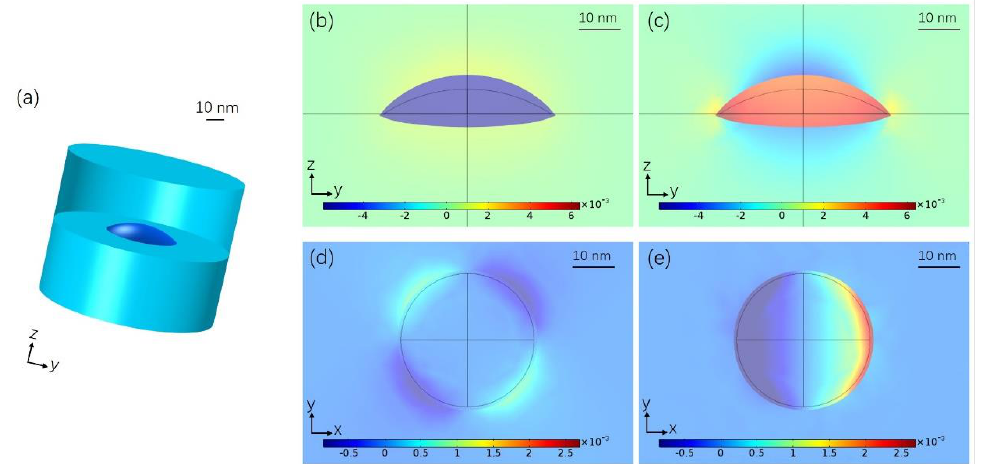
Figure 1. ( a ) Three-dimensional schematic of the proposed InPBi QD structure. The strain distribution of ( b ) ε xx and ( c ) ε zz in the yz plane; ( d ) ε xy and ( e ) ε xz in the xy plane for the InPBi QDs in InP with Bi content of 6%, diameter of 40 nm and height of 6 nm. The deformation is exaggerated by 100 times.